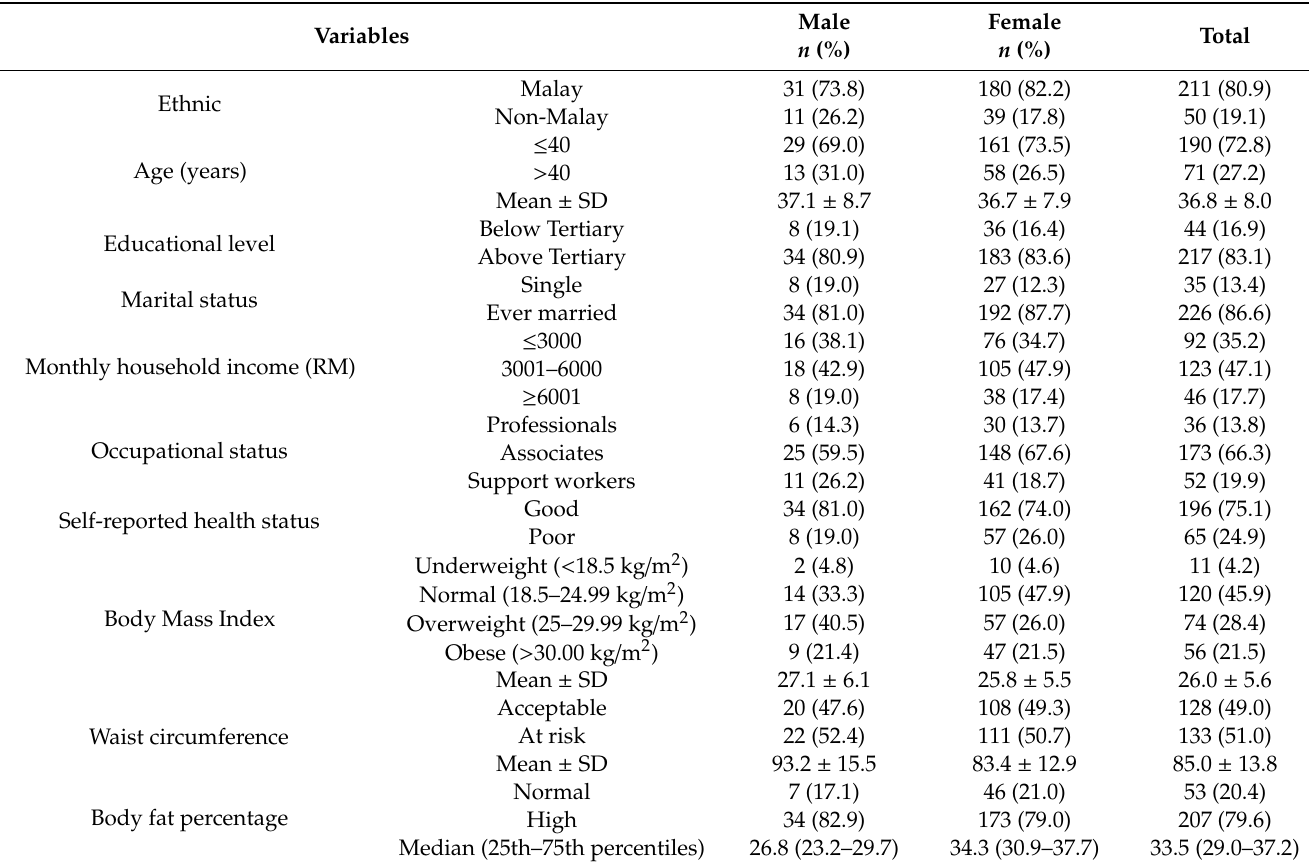
Table 2. Socio-demographic characteristics and obesity indices among the primary healthcare